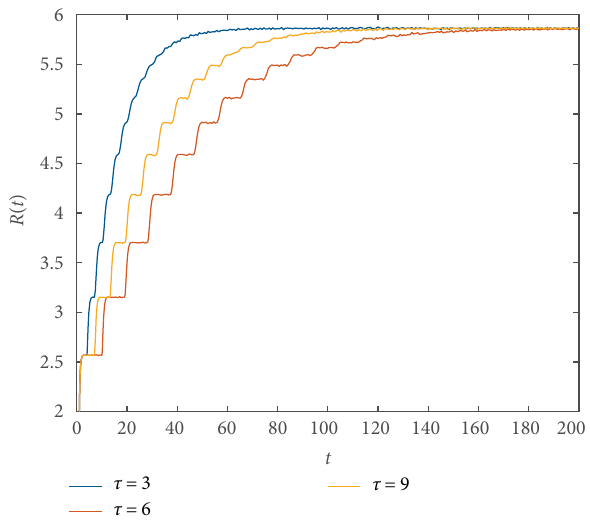
Figure 5: Asymptotic behavior of ̃휎 = 3, 훽 = 2,푅 0 = 2